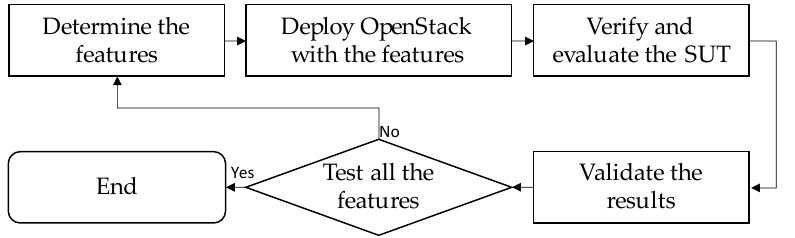
Figure 9. Verification procedures.